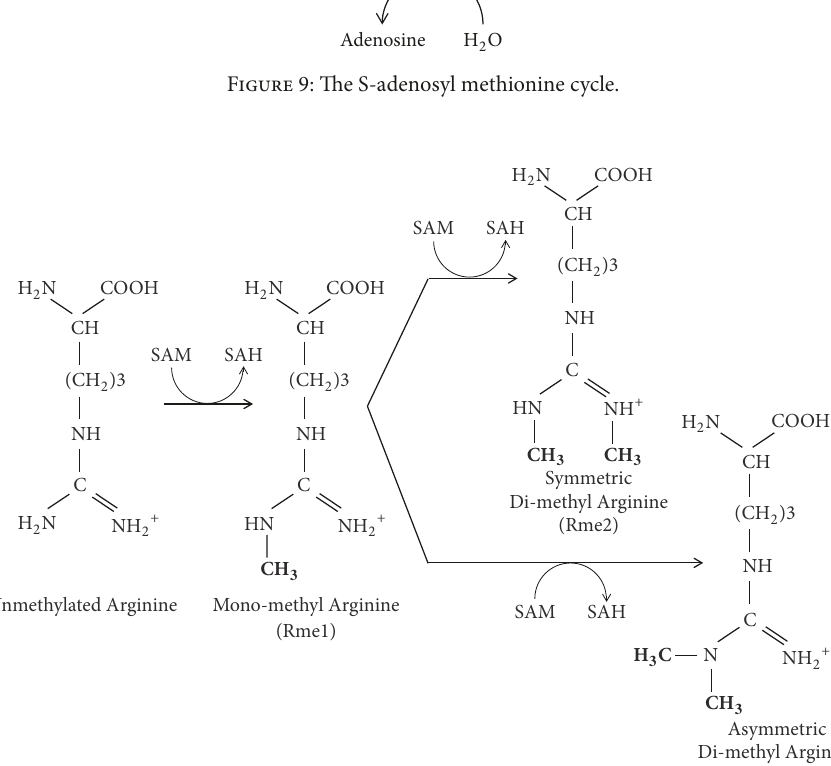
Figure 10: Formation of mono-, symmetrical, and asymmetrical